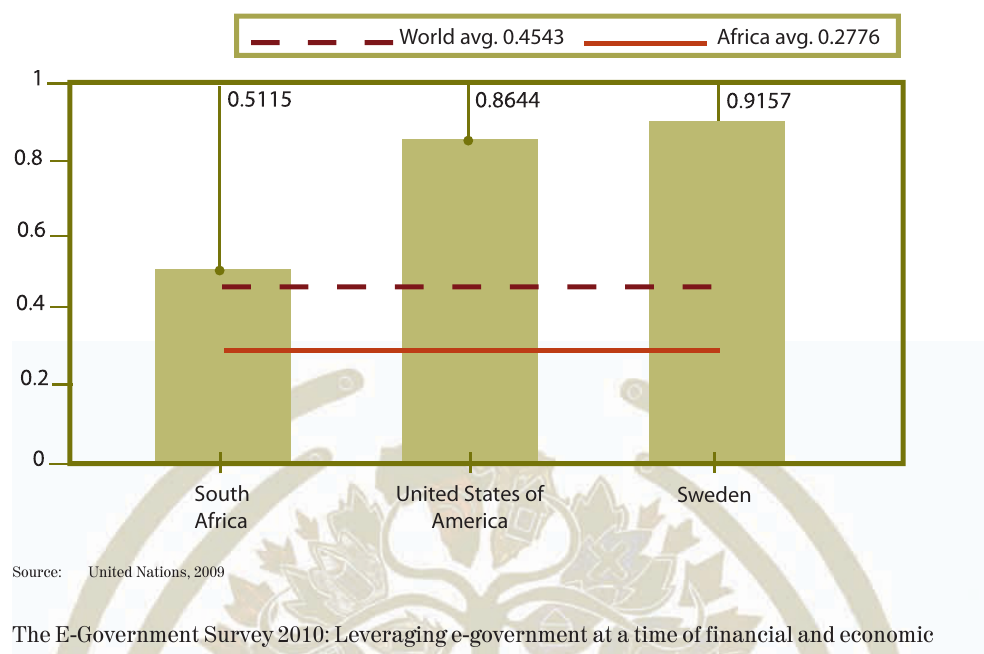
FIGURE 3: 2008 E -READINESS